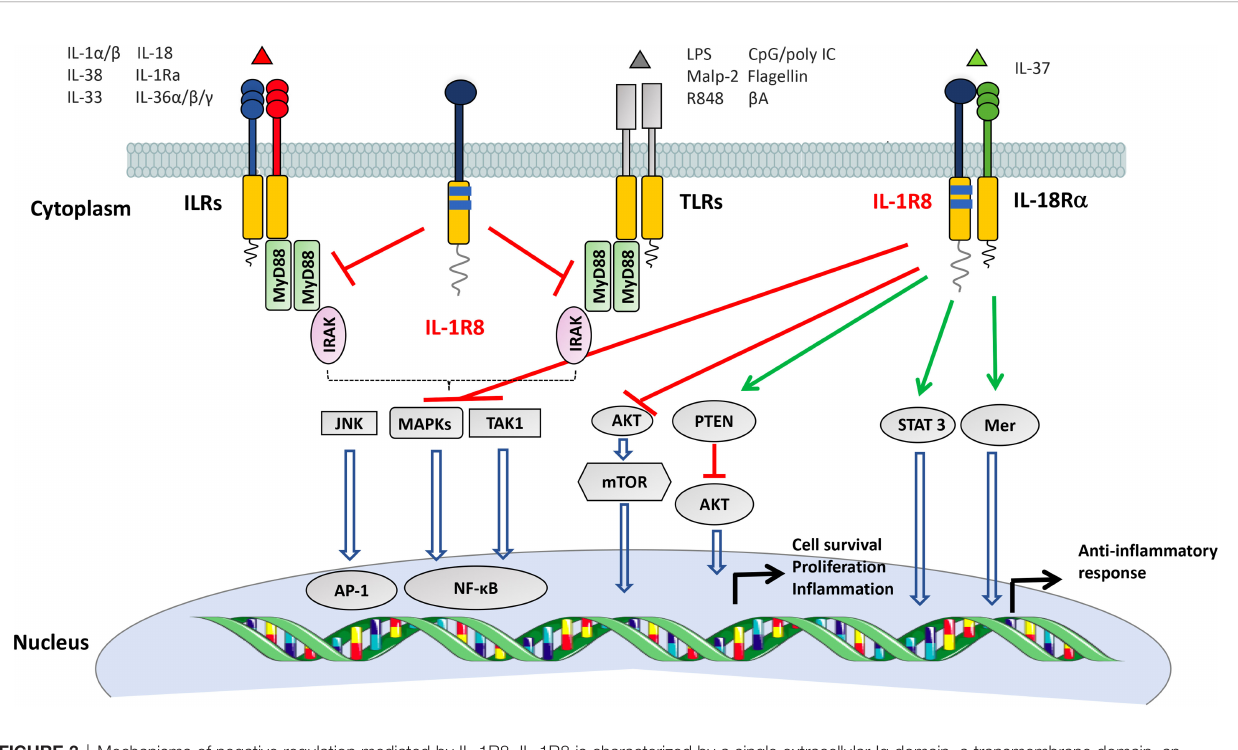
FIGURE 3 | Mechanisms of negative regulation mediated by IL-1R8. IL-1R8 is characterized by a single extracellular Ig domain, a transmembrane domain, an intracellular TIR domain and an unusually long tail of 95 residues. The IL-1R8 TIR domain differs from the TIR domains of other ILRs for the substitution of two conserved residues (Ser447 and Tyr536 with Cys222 and Leu305), suggesting unconventional signaling. IL-1R8 inhibits the signalling pathways downstream ILRs and TLRs by competing with the recruitment of MyD88 and IRAK at the TIR domain, thus dampening the signaling pathways involved in NF- k B and JNK activation. In addition, in T, NK and epithelial cells, IL-1R8 negatively regulates the activation of the mTOR pathway. IL-1R8, together with IL-1R5, is part of the signaling receptor of the anti-in fl ammatory molecule IL-37. The IL-37//IL-1R5//IL-1R8 tripartite complex inhibits MAPK, NF- k B, mTOR, TAK1 and Fyn, and activates STAT3, Mer, PTEN and p62(dok) signalling, thus leading to an anti-in fl ammatory